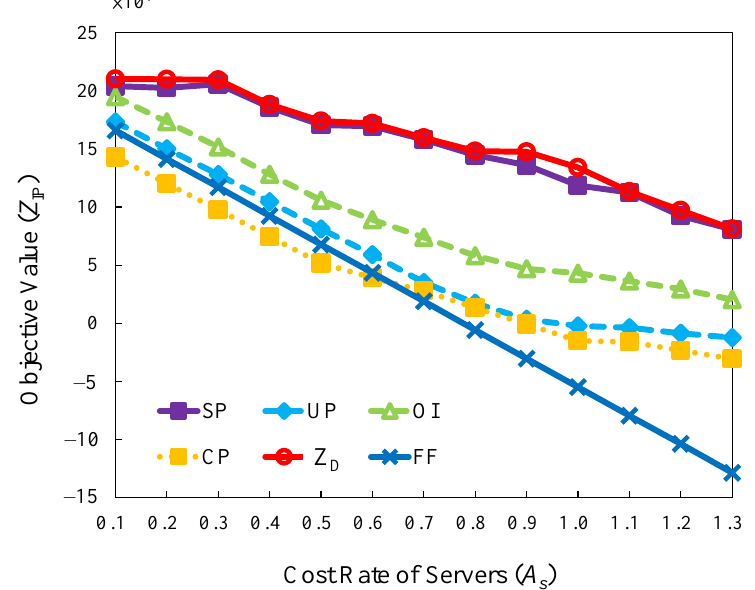
Figure 11. Objective value versus different cost